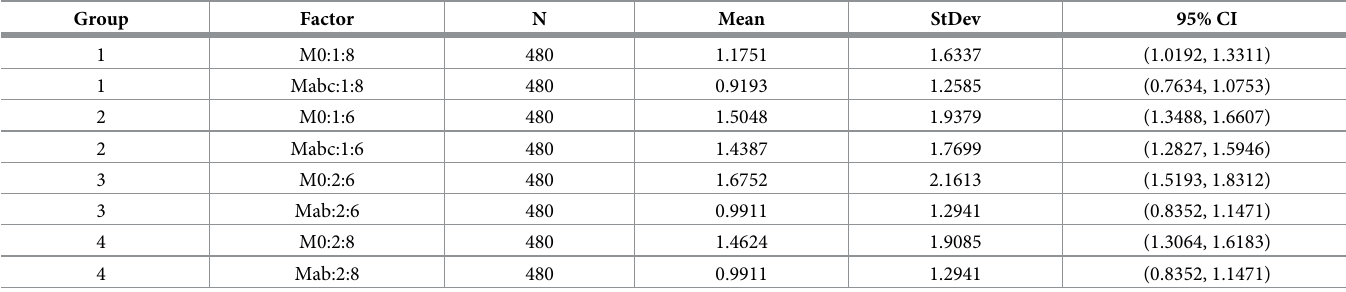
Table 11. Detail results of simulation.